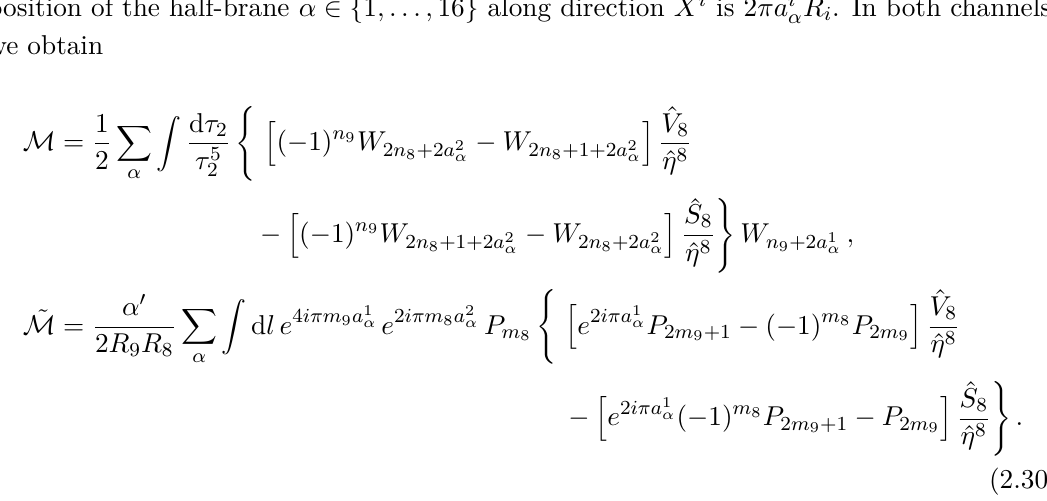
Figure 2. Example of vector field longer the vector norm